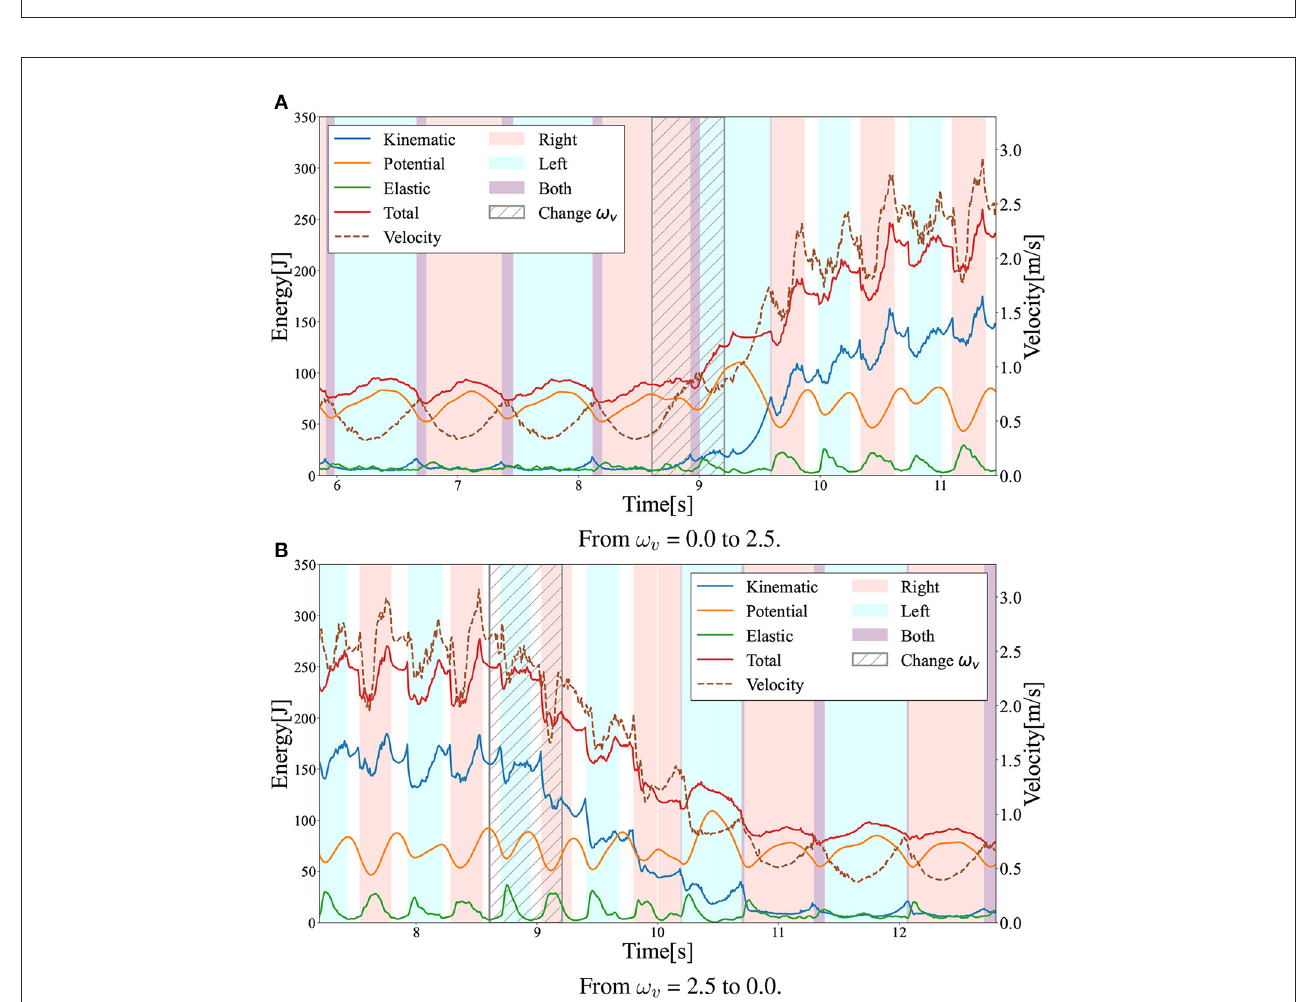
FIGURE10 Gait transition between walking and running with changes in the ω v value. The graph shows the time evolution of kinetic (blue), potential (orange), elastic (green), and total (red) energies during the gait transition. The dotted lines represent locomotion velocity. The pink and sky blue areas represent the right and left single stance phase, respectively. The purple and white areas represent the double stance (DS) and flight (F) phases. We linearly changed the ω v in the shaded period. (A) From ω v = 0.0 to 2.5. (B) From ω v = 2.5 to 0.0.